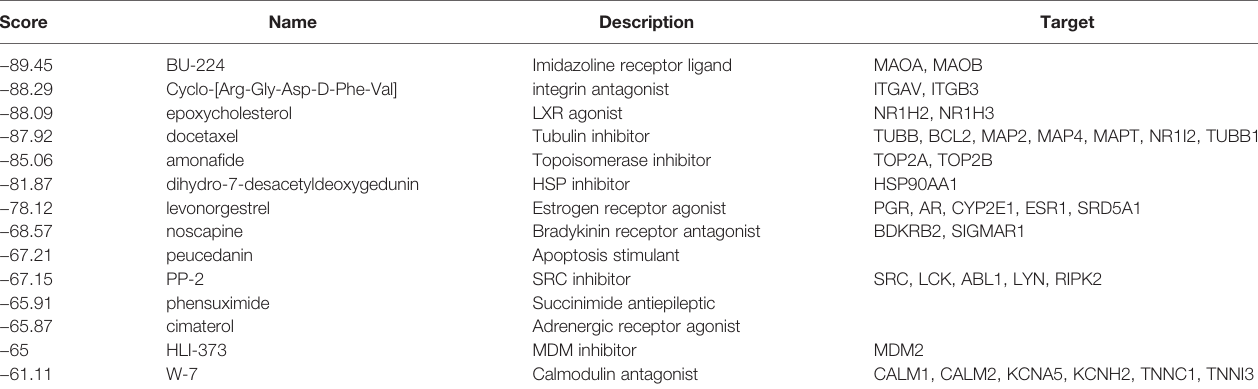
TABLE 2 | Results of CMap analysis (score < −